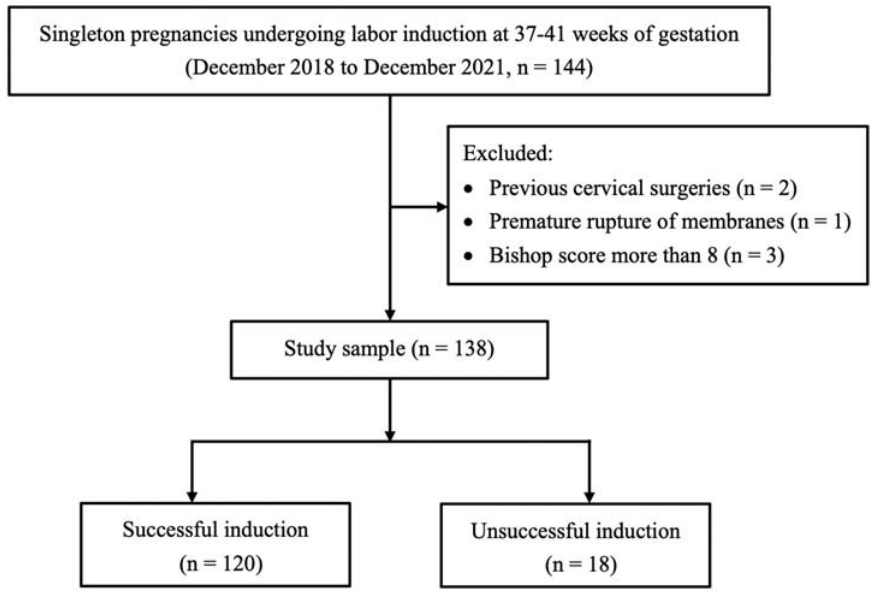
Figure 1. Study flowchart.